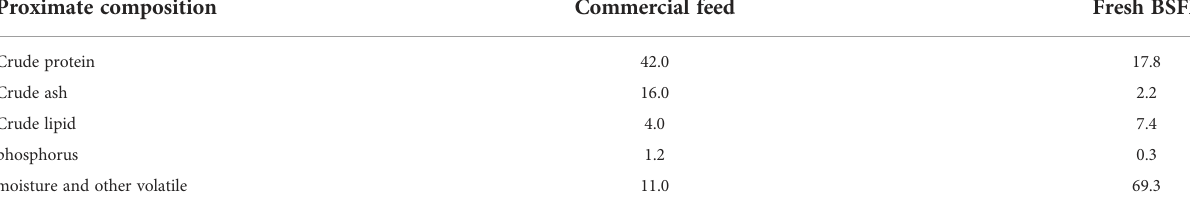
TABLE 1 Proximate composition of commercial feed and fresh BSFL (%